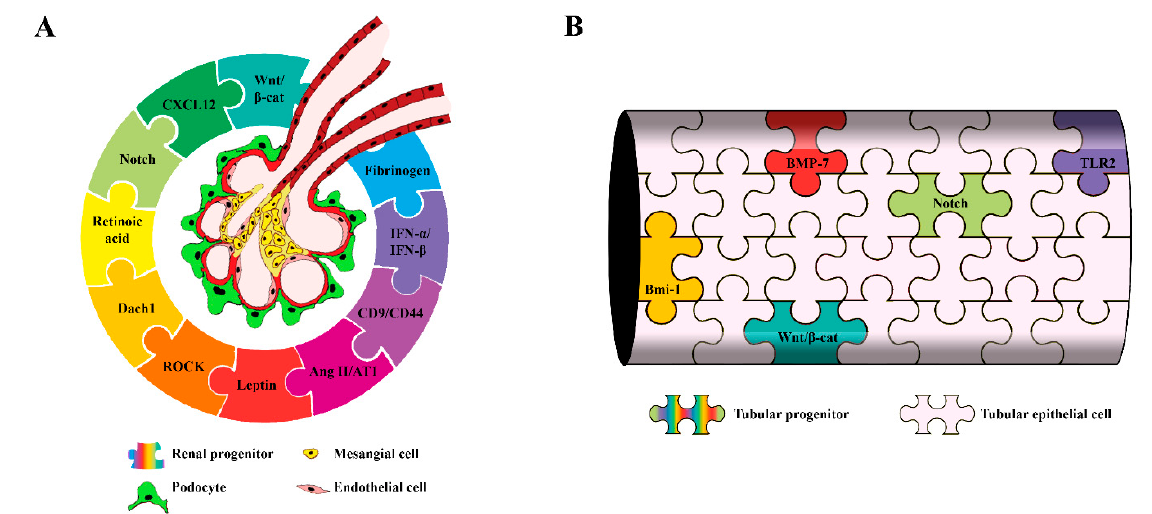
Figure 1. Main molecular mechanisms controlling renal progenitor responses in physiological and pathological conditions: ( A ) glomerular progenitors and ( B ) tubular progenitors. β -cat: β -catenin, CXCL12: C-X-C Motif Chemokine Ligand 12, Dach1: Dachshund homolog 1, ROCK: Rho kinase, Ang II/AT1: Angiotensin II/Angiotensin II receptor, IFN- α /IFN- β : interferon- α and interferon- β , BMP-7: bone morphogenetic protein 7, Bmi-1: B lymphoma Mo-MLV insertion region 1 and TLR2: Toll-like receptor 2.